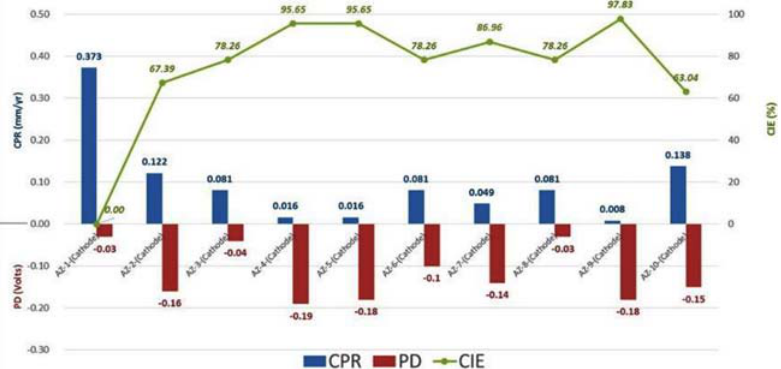
FIG. 6. RELATIONSHIP BETWEEN PD, CPR AND CIE